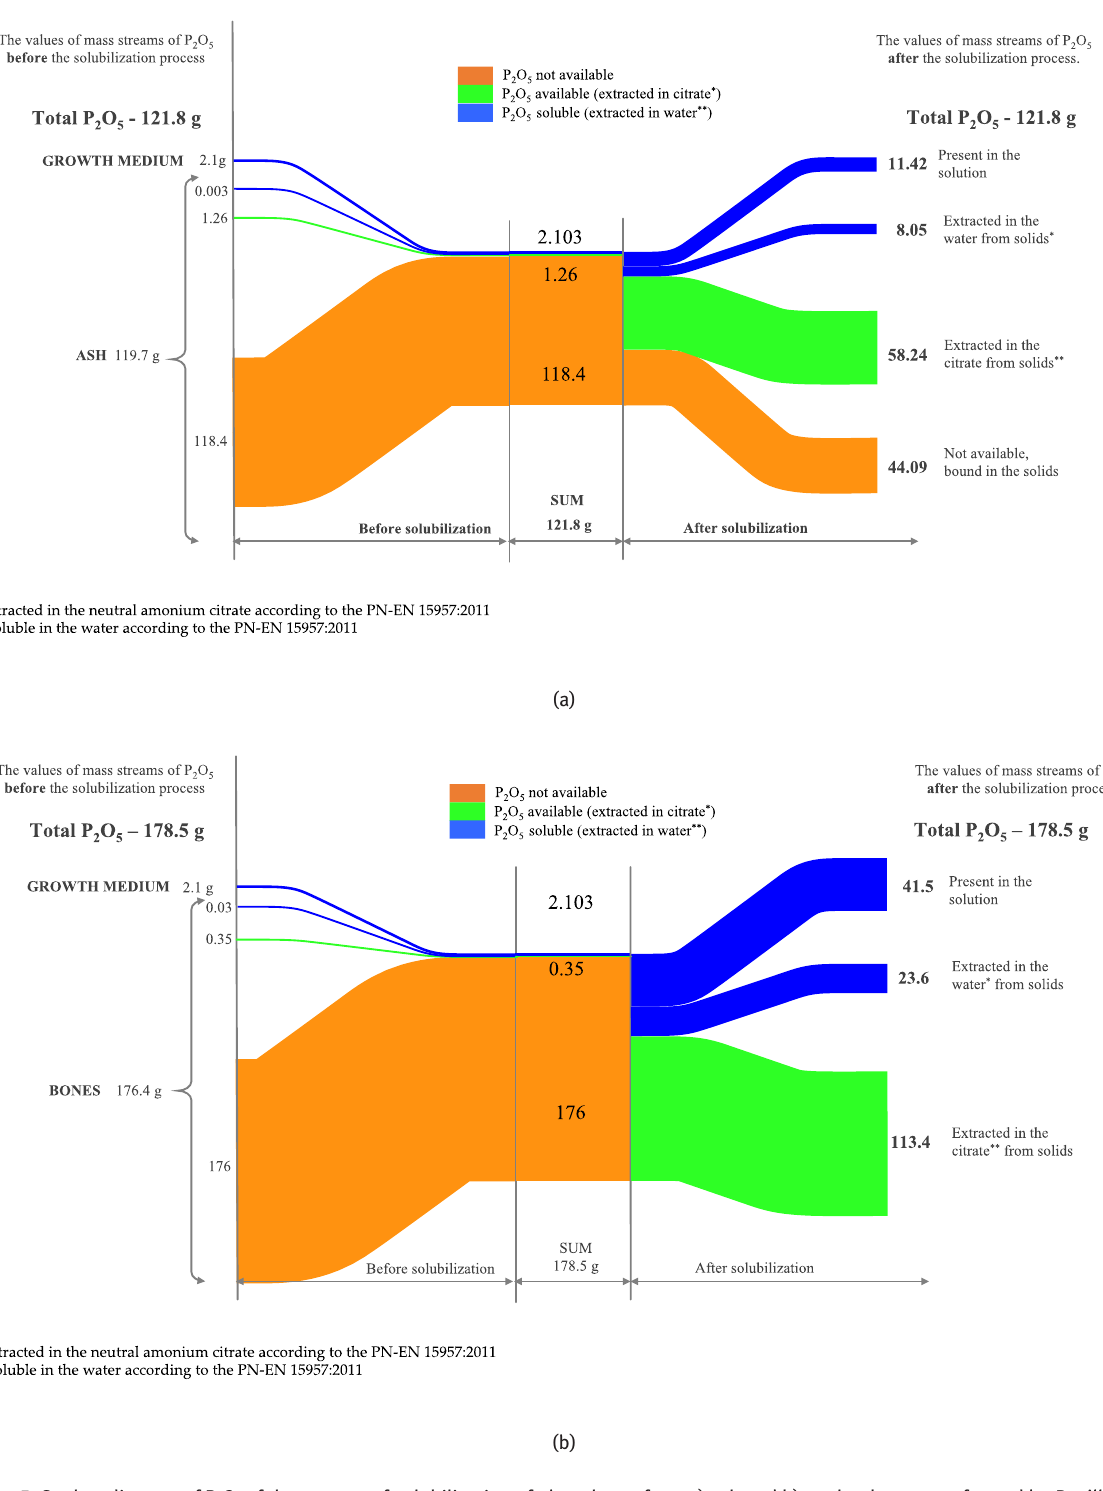
O of the process of solubilization of phosphates from a) ash and b) poultry bones, performed by Bacillus 2 5